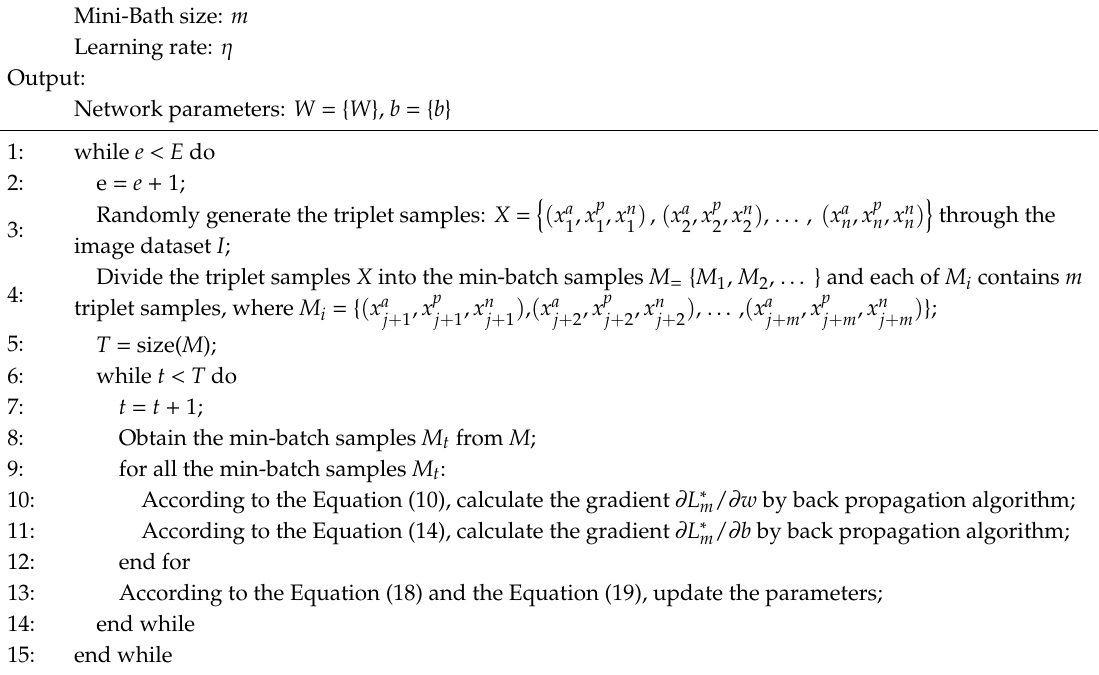
Algorithm 1 : Training the TSPP-Net